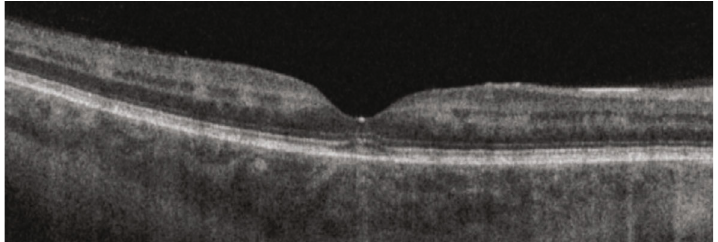
Figure 2: OCT B-scan at presentation demonstrating inner nuclear layer hyperre fl ectivity at the macula suggestive of paracentral acute middle maculopathy.